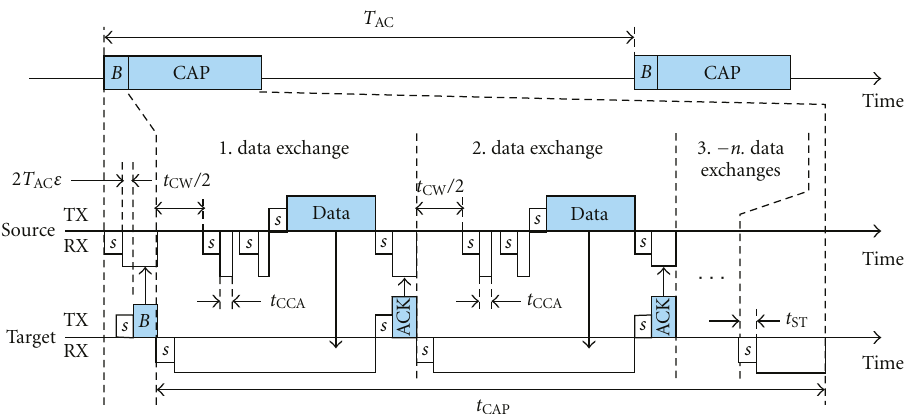
Figure 12: The activity of radio in IEEE